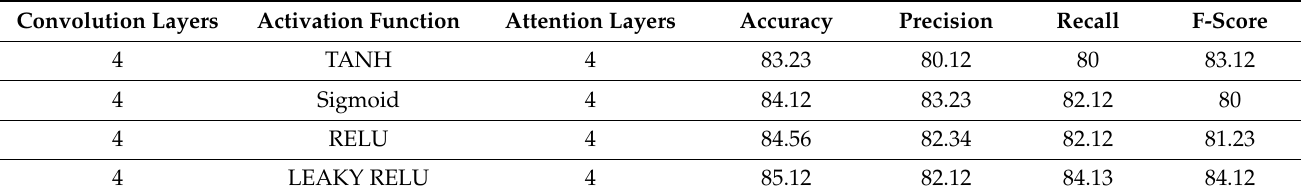
Table 4. Comparison of different activation